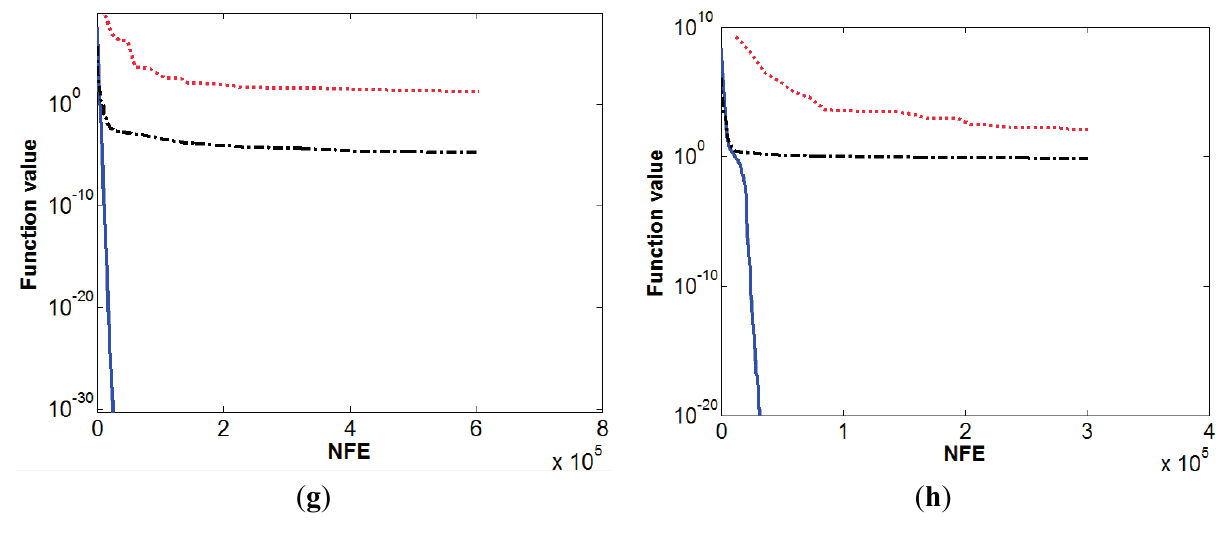
( g ) ( h ) Figure 6. Evolution of mean best values for MA, KHA and MAKHA for: ( a ) Goldstein–Price ( b ) Himmelblau, ( c ) Levy 13, ( d ) Schaffer functions, ( e ) Zettl, ( f ) Helical Valley, ( g ) Powell and ( h )